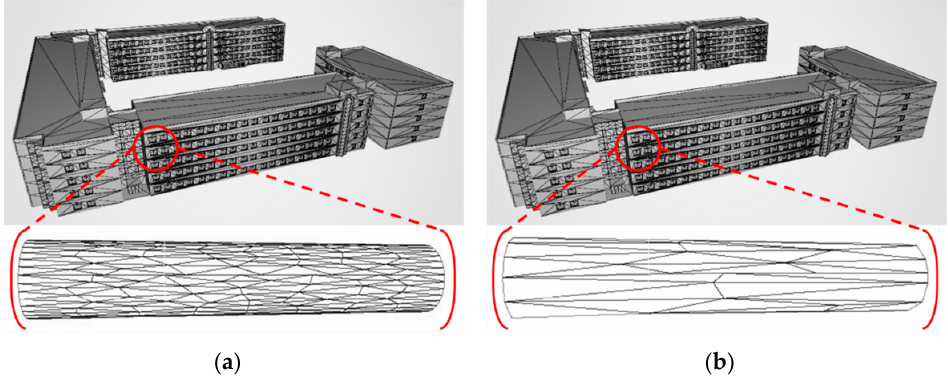
Figure 8. SKKU No. 2 engineering building models and internal round-column structure (mesh form): ( a ) original, and ( b ) optimized. Table 2. SKKU No. 2 engineering building original and optimized parameters.